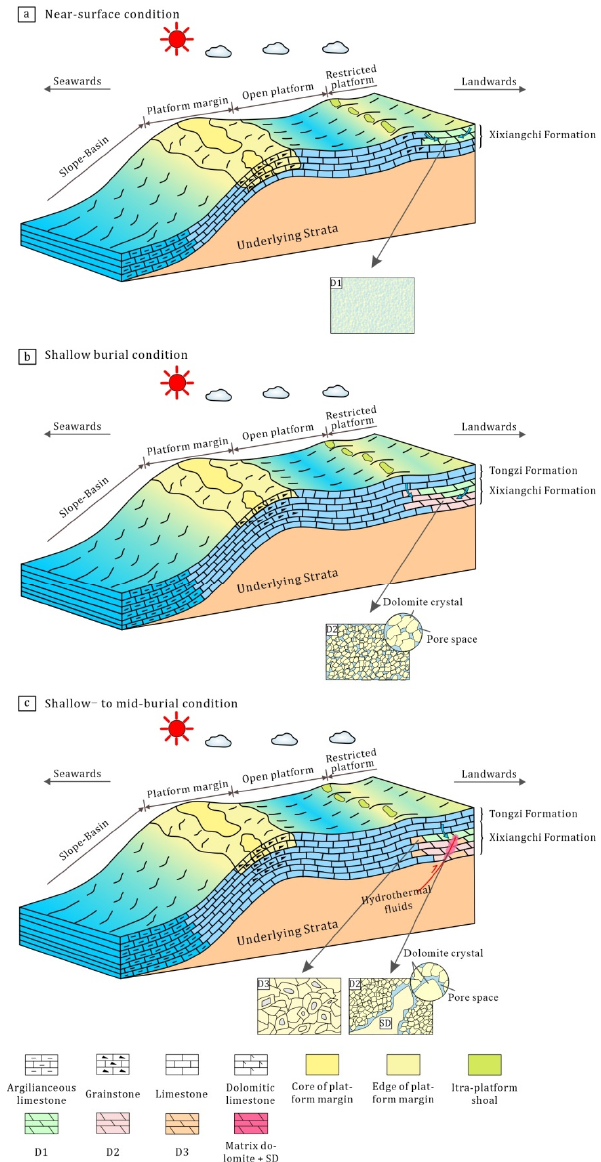
Figure 11. Schematic showing the conceptual dolomitization model for the Xixiangchi Formation dolomites in the Eastern Sichuan Basin (modified from [86]). Note the Middle-Upper Cambrian Xixiangchi Formation underlies the Lower Ordovician Tongzi Formation. D1 dolomite is interpreted to be formed by penecontemporaneous dolomitization in the near-surface environment ( a ). D2 dolomite is likely formed by the post-penecontemporaneous seepage-reflux dolomitization or the recrystallization of D1 in a near-surface or a shallow burial environment ( b ). D3 dolomite is formed by the overgrowth or recrystallization of D1 and D2 dolomites in a shallow- to mid- burial environment, which is followed by the SD dolomite in association with hydrothermal dolomitization ( c ).